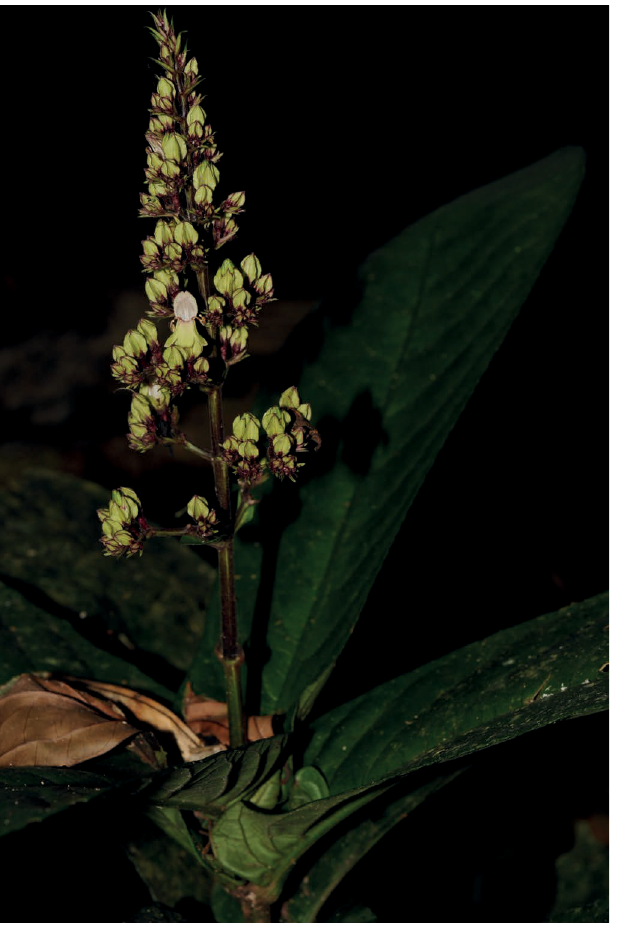
Figure 2 – Field photograph (by M. Cheek) of J. gigantophylla in lowland evergreen forest ( Cheek 17553 ).